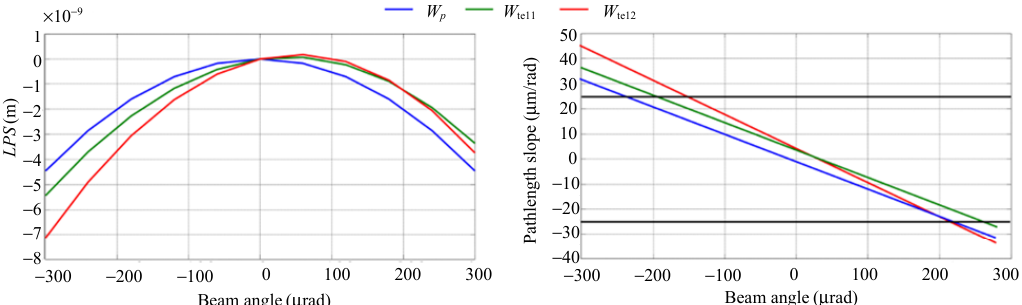
Fig. 8 Optical path signals caused by the interference between the Gaussian beam and three different cases for the flat-top beam. Its rate of change in the optical path noise exceeds the TTL specification requirement of 25 μ m / rad .